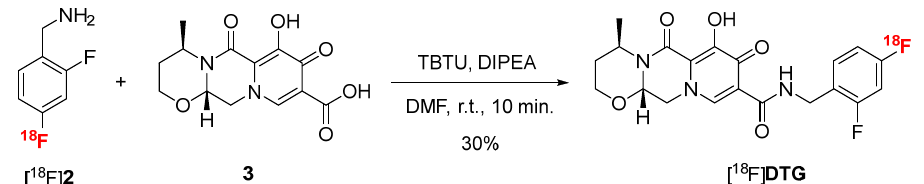
Table 3. Optimization of the nitrile reduction using NaBH 4 (2M) and NiCl 2 · 6H 2 O as reducing agents.